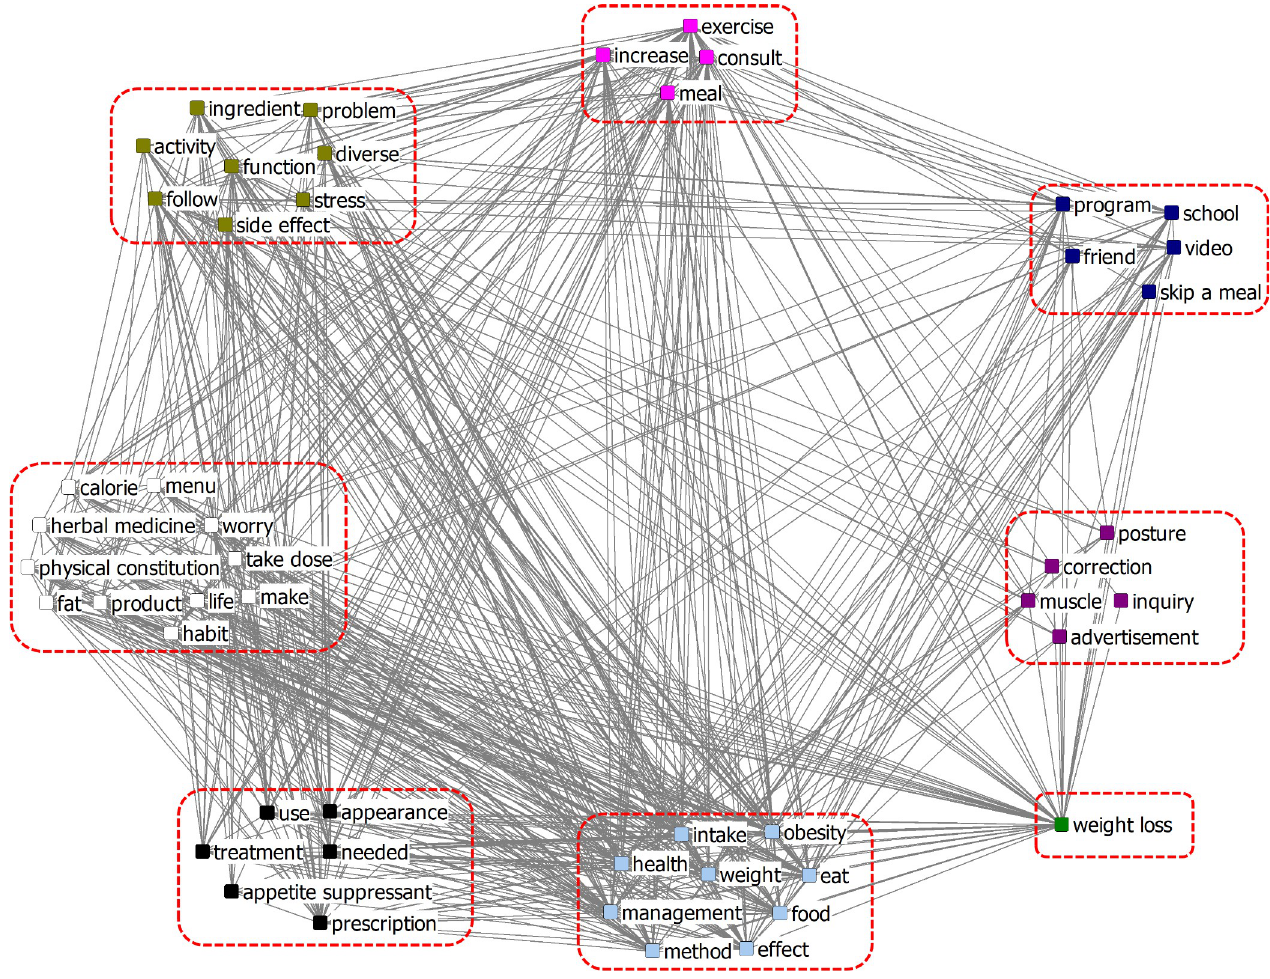
Fig 2. CONCOR analysis of News Network of the adolescents’ diet